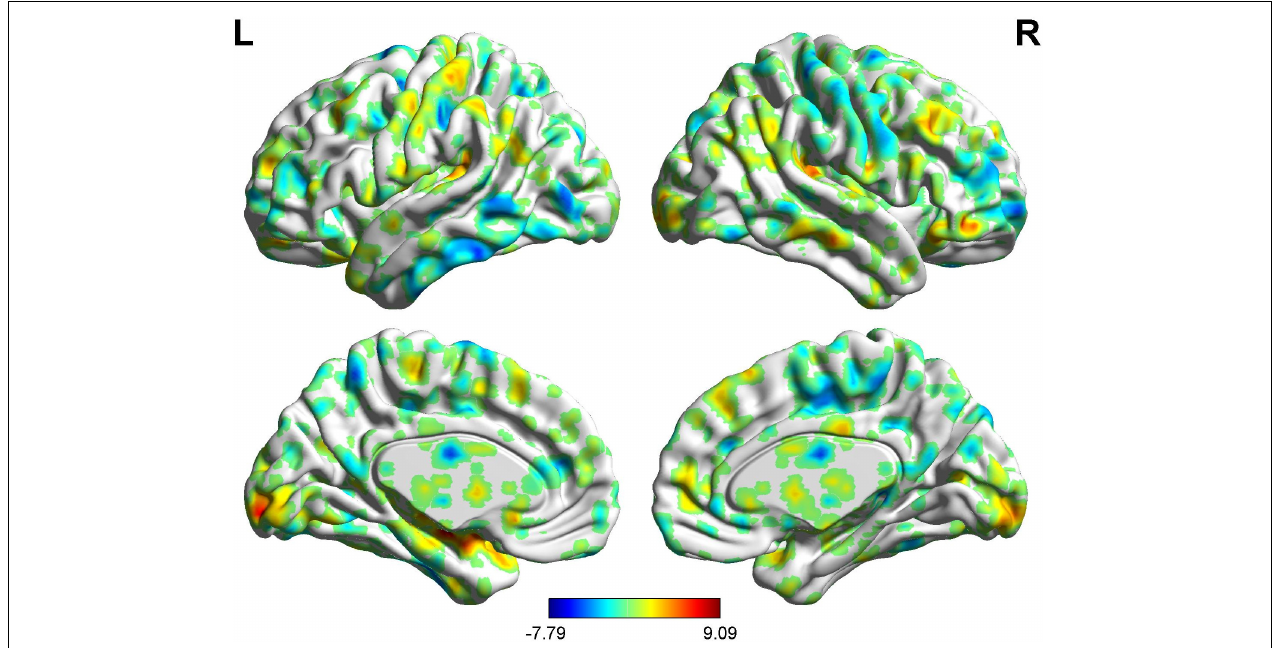
FIGURE 10 | Brain areas showing functional connectivity with the rACC in nocebo response in female participants. Color scale represents the Z -score. Red = nocebo > pain; blue = pain >